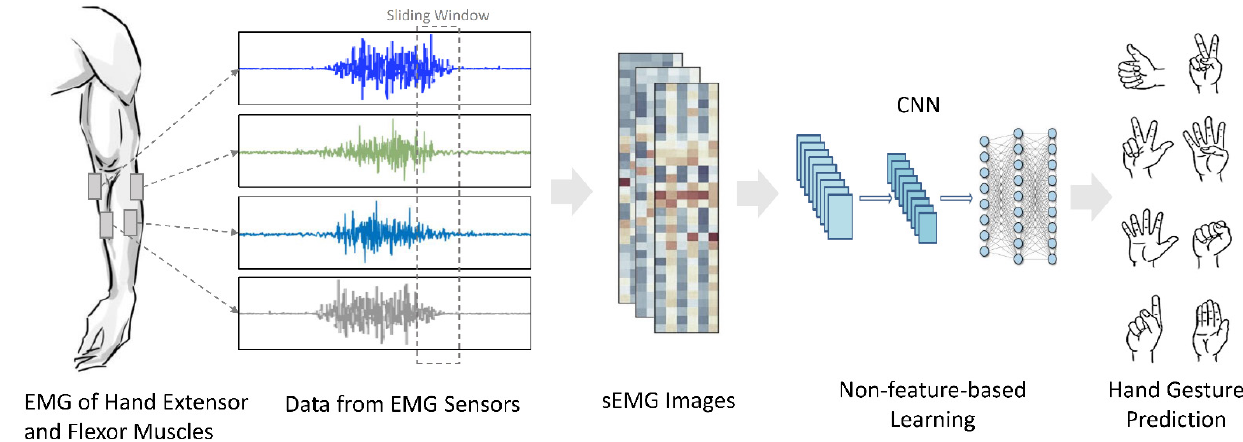
Figure 3. Non-feature-based learning using a Convolutional Neural Network (CNN) for hand gesture classification using NinaPro dataset.